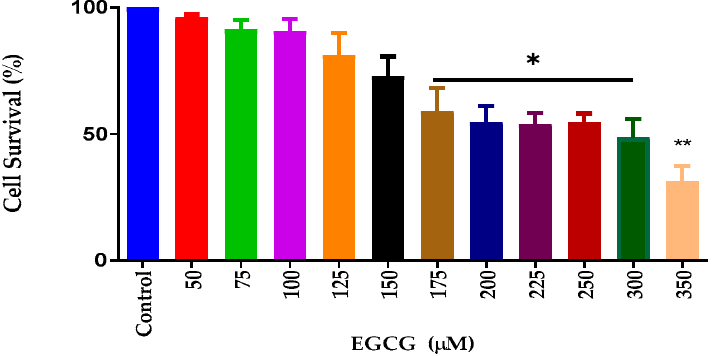
Figure 1. EGCG caused a concentration-dependent decrease in cell viability of BV-2 for concentra- tions ≥ 175 µ M. AlamarBlue™ assay was used to assess cell viability. The X -axis represents the different concentrations of EGCG, and the Y -axis represents cell survival (%). As shown in the above graph, EGCG caused a concentration-dependent decrease in cell viability of BV-2 for concentrations ≥ 175 µ M. EGCG 150 µ M was chosen as the concentration for the remaining experiments. Values represent the mean ± SD, * p ≤ 0.05, ** p ≤ 0.01.